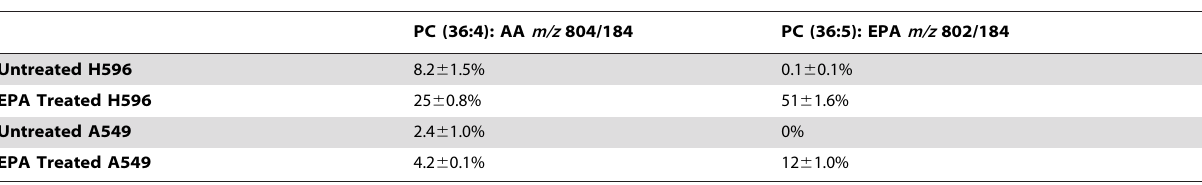
Table 1. Ratio of PUFA PC to PC head group.